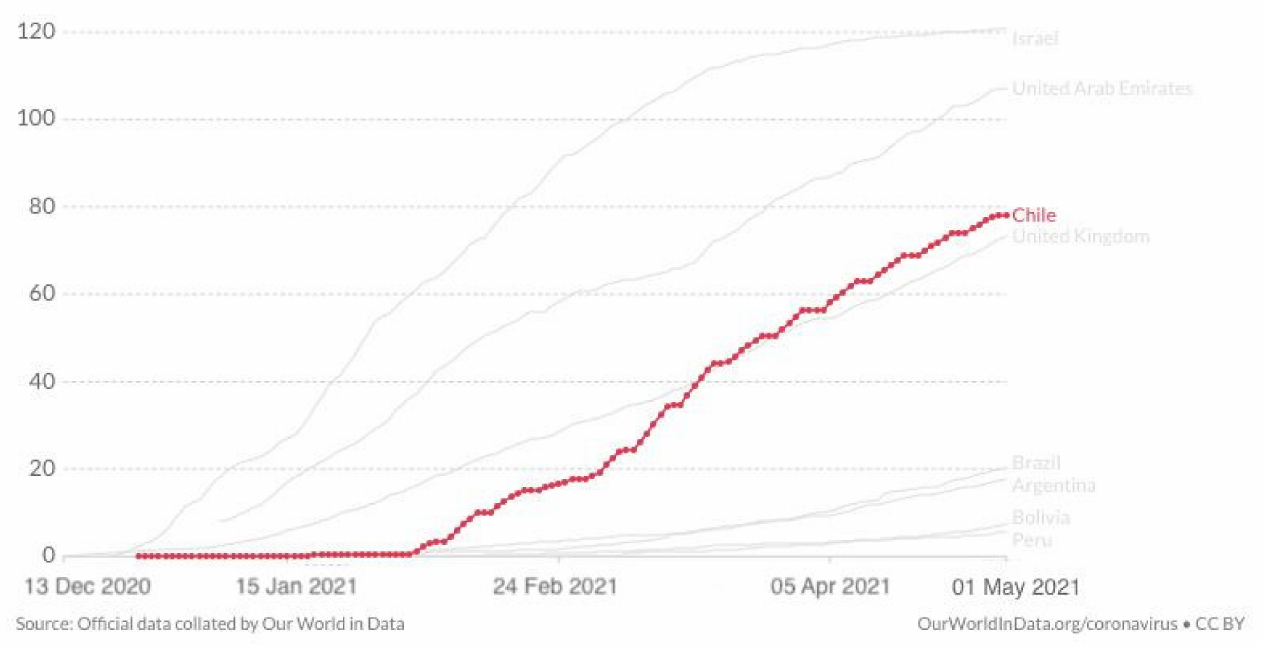
Figure 4. COVID-19 vaccine doses administered per 100 people until 30 April 2021, including comparison with the region (Argentina, Brazil, Bolivia, Peru) and other leading vaccination nations (Israel, UAE, UK) www.ourworldindata.org (accessed on 1 May